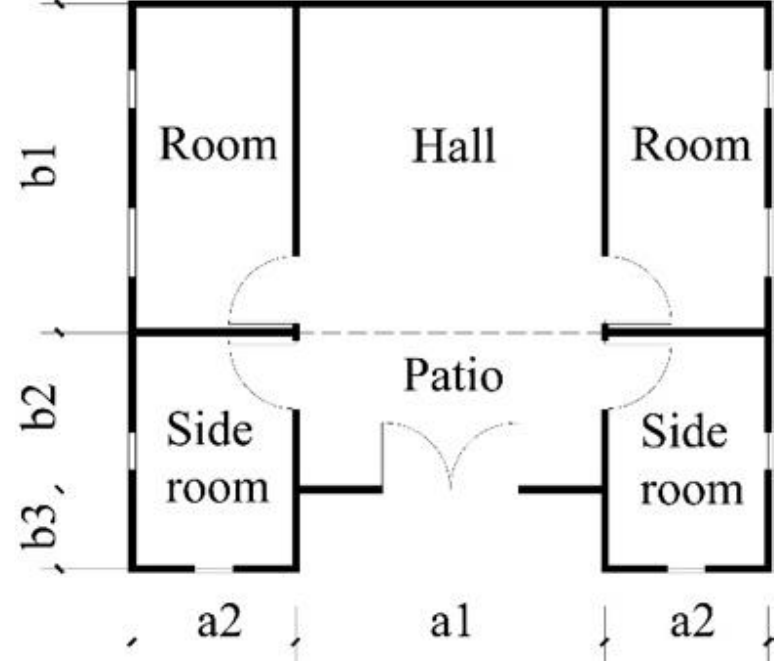
Figure. 6 The width and depth of Xiashanhu houses(a1: HW, a2: RW, b1: HD, b2: PD, b3: